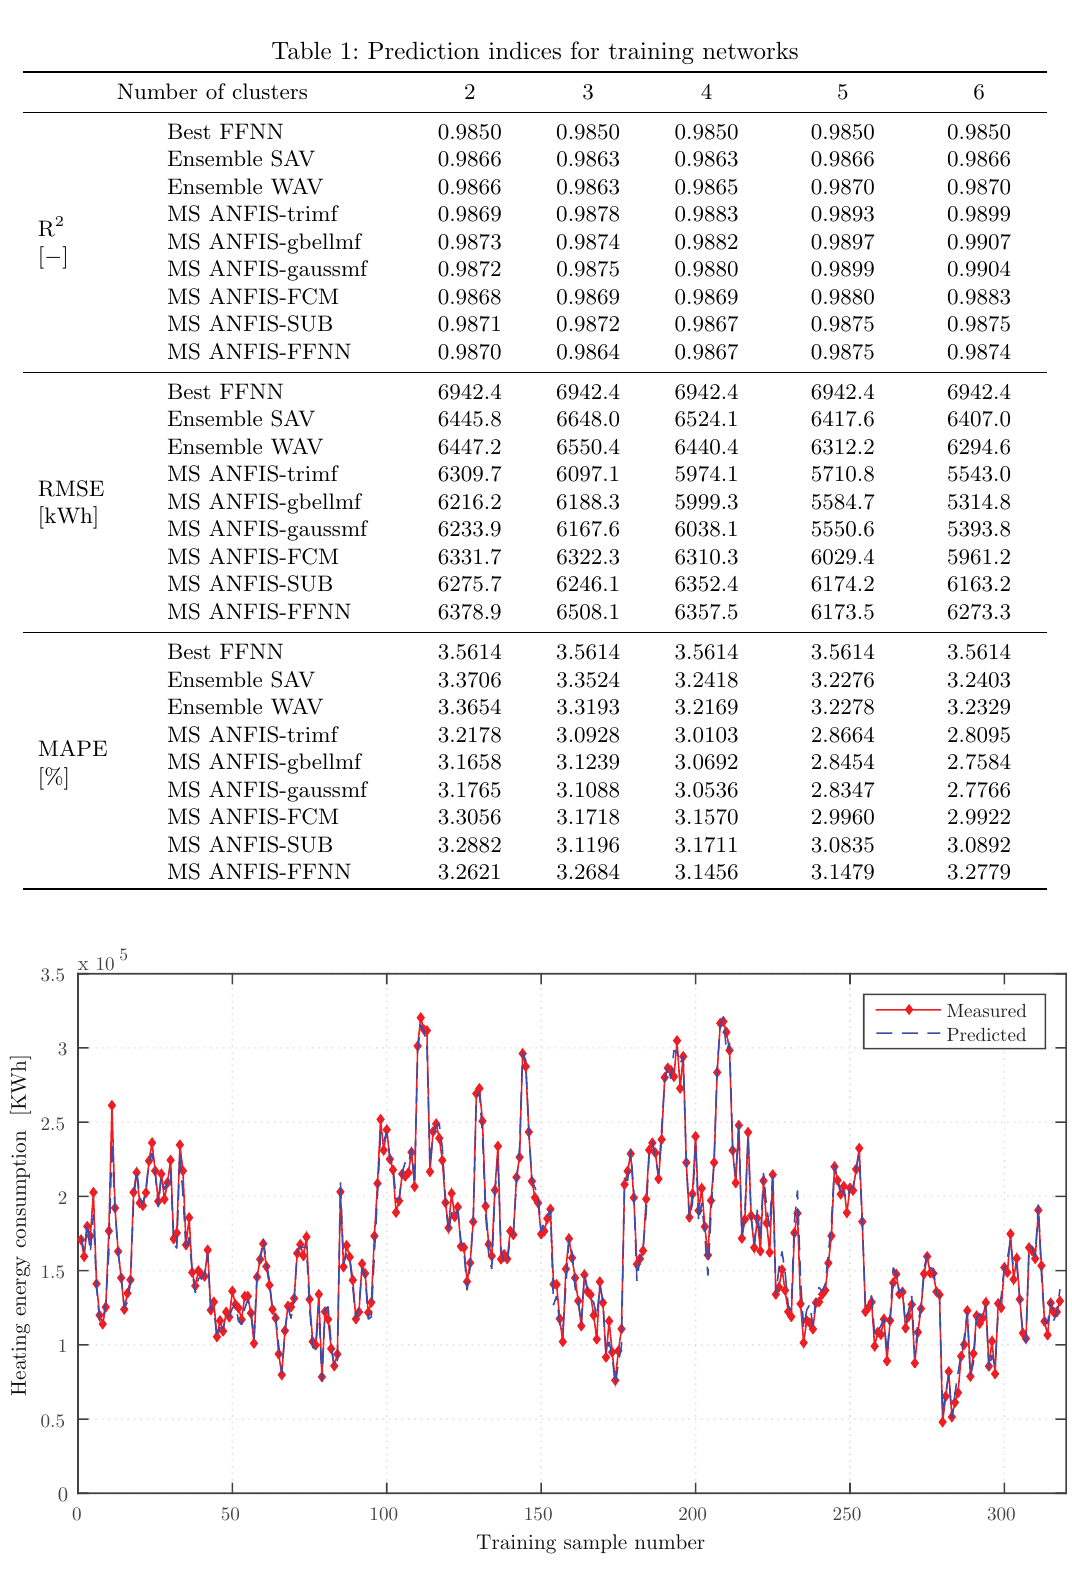
Figure 8: Prediction results of multistage ensemble ANFIS FCM with 5 clusters for training